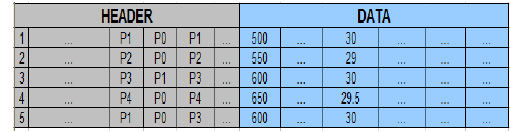
Figure 15. Exampleof routinglocal